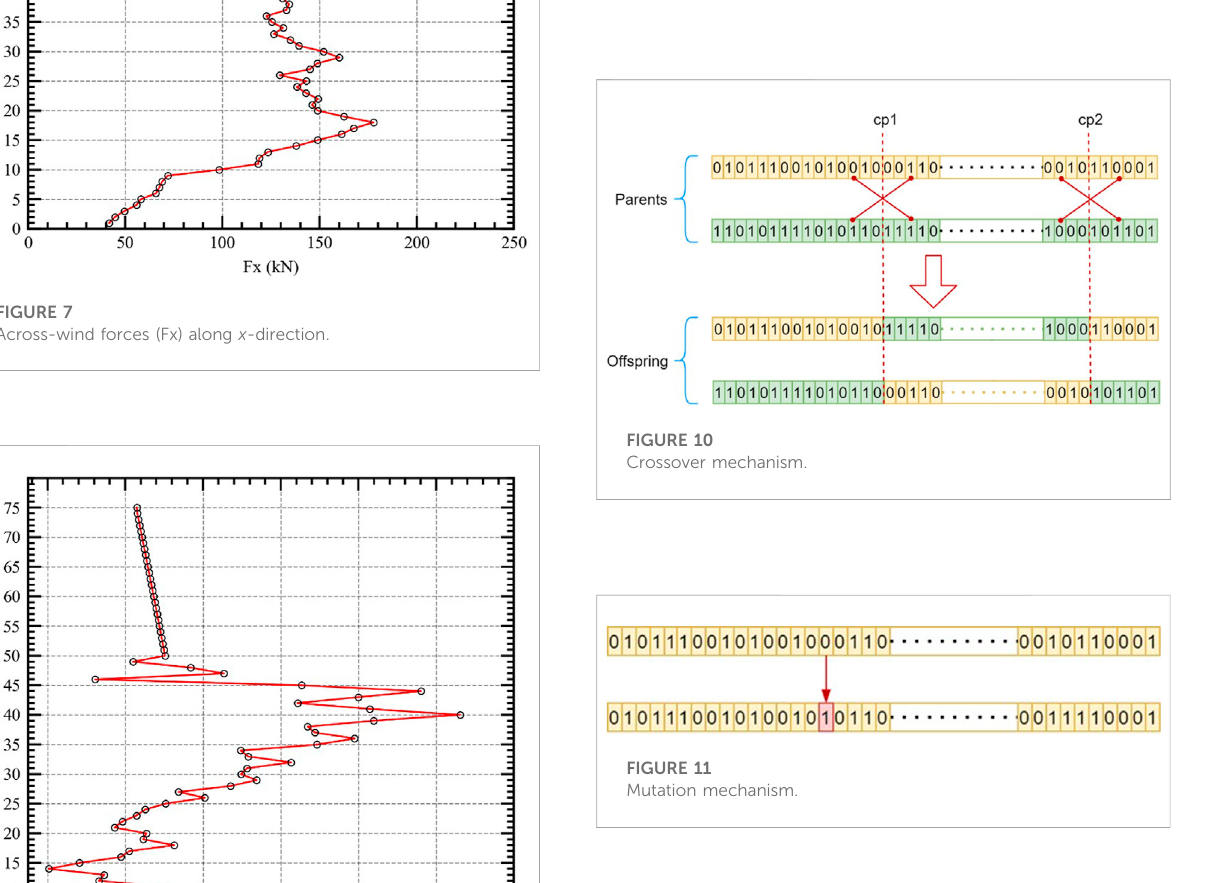
FIGURE 9 Binary chromosome representing individual solution.